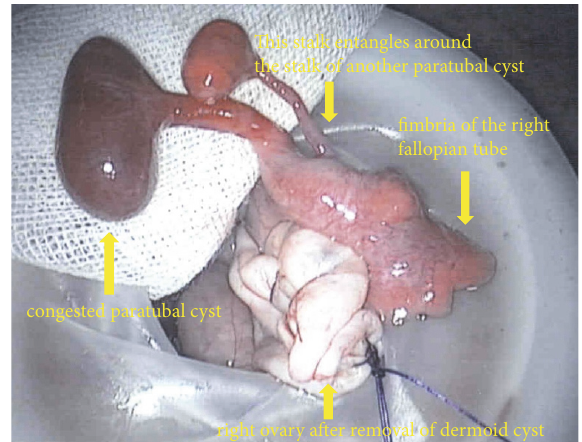
Figure 3: Intraoperative findings from the extracorporeal